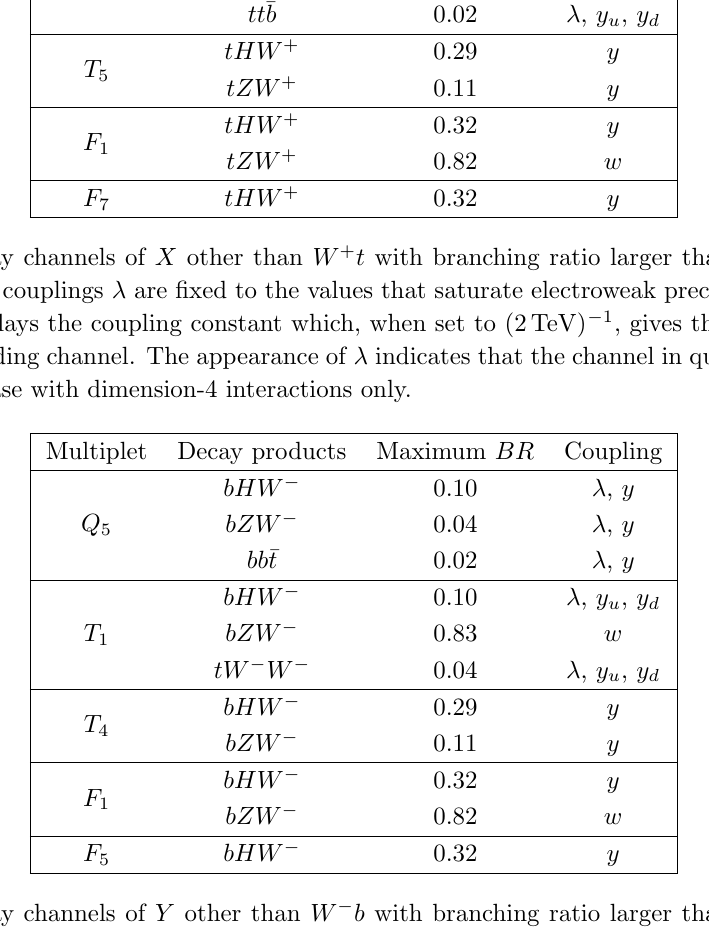
Table 11 . Decay channels of Y other than W (cid:0) b with branching ratio larger than 0.01 for M = 2 TeV, when the couplings (cid:21) are (cid:12)xed to the values that saturate electroweak precision limits. The last column displays the coupling constant which, when set to (2 TeV) (cid:0) 1 , gives the maximum BR in the corresponding channel. The appearance of (cid:21) indicates that the channel in question is present already in the case with dimension-4 interactions